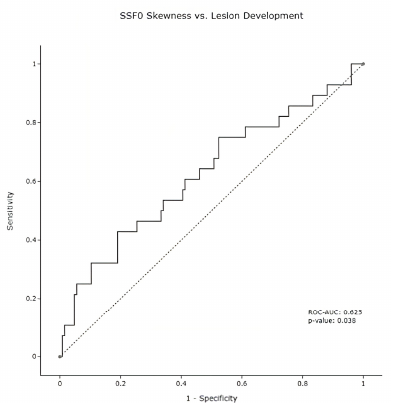
Figure 4. Lesion Skewness ROC Curve. Overall, SSF0 skewness was measurable on 154 pancreatic regions. Skewness measurements at baseline timepoints achieved a 0.625 ROC-AUC when discriminating for future lesion development, with a statistical significance of 0.038.